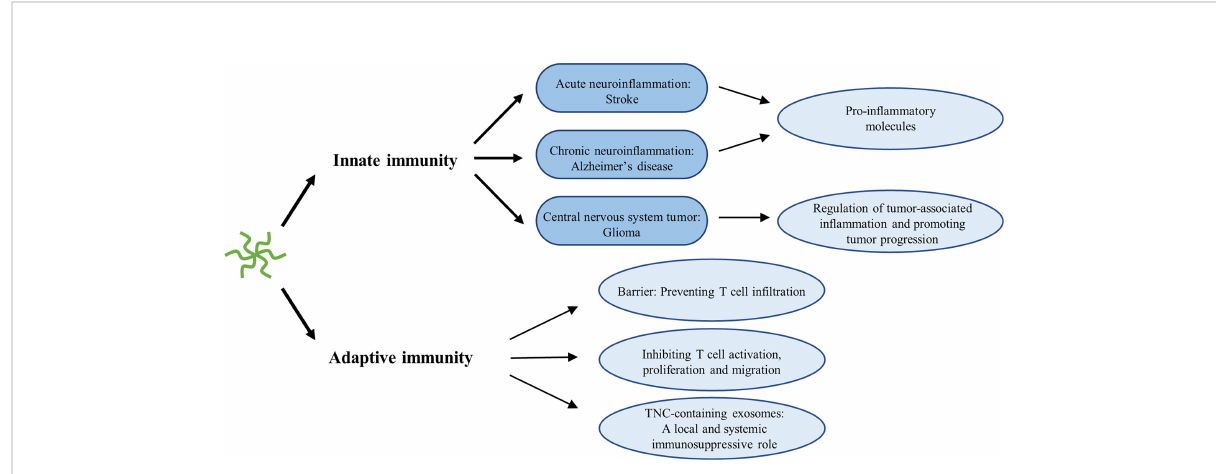
FIGURE 5 Immunomodulatory role of TNC in neuroin fl